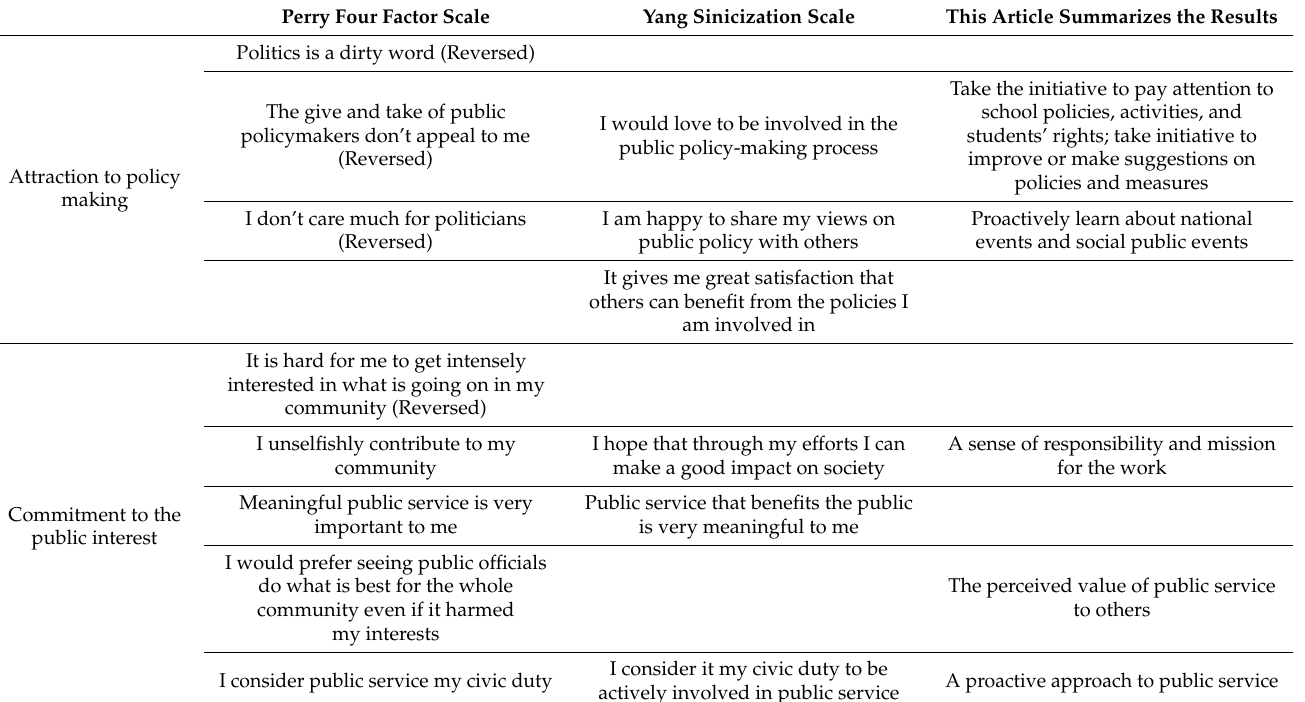
Table 9. Comparison of PSM measurement